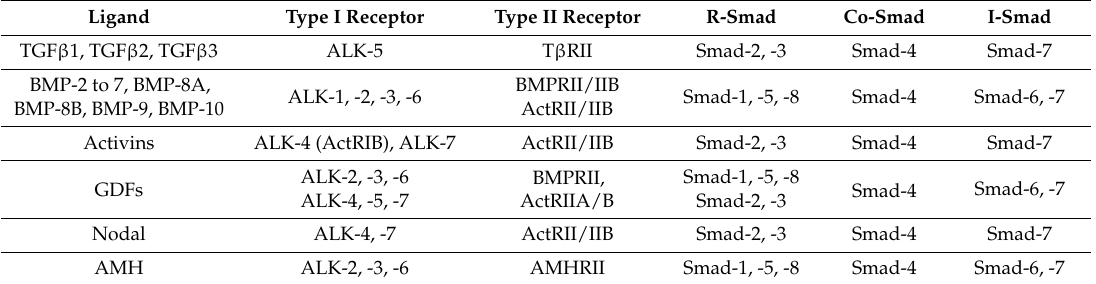
Table 1. Main components of the TGF β superfamily signaling canonical